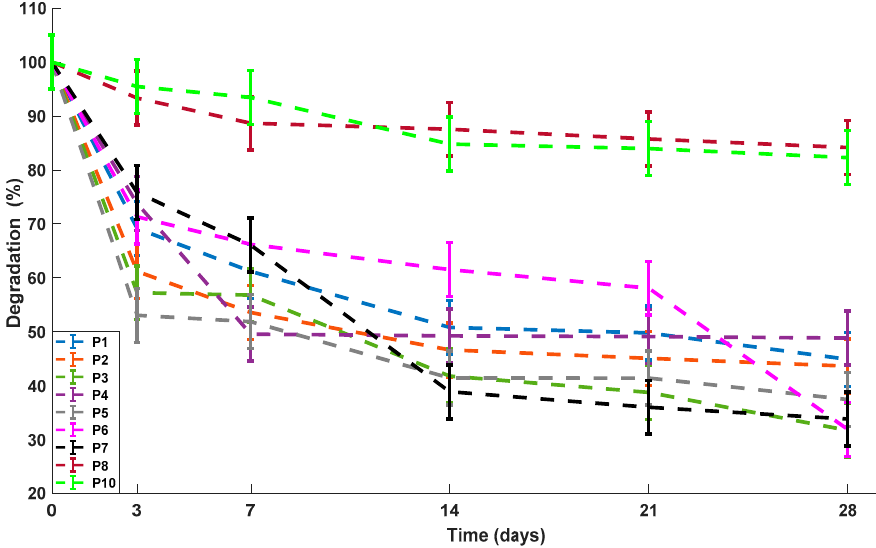
Figure 9. Percentage of degradation for the ternary blend scaffolds and controls.